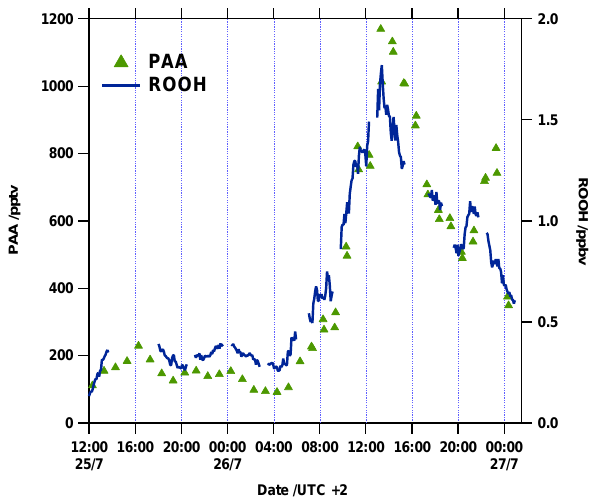
Fig. 3. Time series of total organic peroxides (ROOH) and PAA between midday 25 July and midnight 26 July 2010.